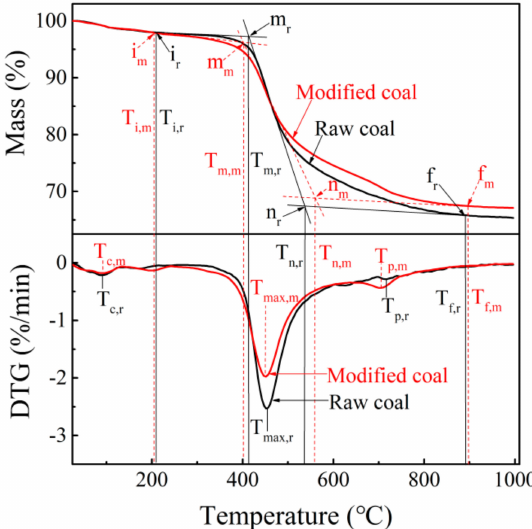
Figure 2. Thermo-gravimetric (TG) and DTG curves of raw coal and modified coal (addition of 0.5 wt.% B 4 C into raw coal) at a heating rate of 10 ◦ C/min. T *,r : represents the characteristic tem- peratures of raw coal; T *,m : represents the characteristic temperatures of modified coal; T c : moisture loss peak temperature; T i : pyrolysis initial temperature; T m : initial temperature of the pyrolysis process with a fast reaction rate; T max : highest pyrolysis peak temperature; T n : finish temperature of the pyrolysis process with a fast reaction rate; T c : second cracking peak temperature; T f : pyrolysis finish